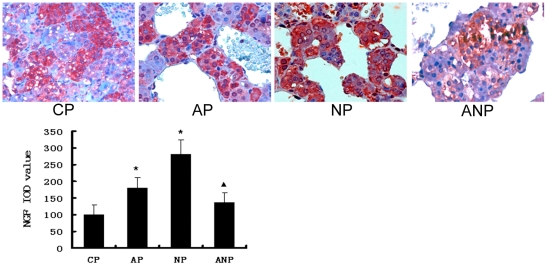
NGF immunochemistry in adrenal medulla of maternal rats.NGF protein in AP and NP rats were significantly higher than that in CP
rats. NGF expression decreased in ANP rats compared with AP rats. IOD
values are expressed as mean ±SEM(n = 8);
* P<0.05 vs CP, ▴P<0.05 vs AP. (The
magnification of the image is 400 ×).